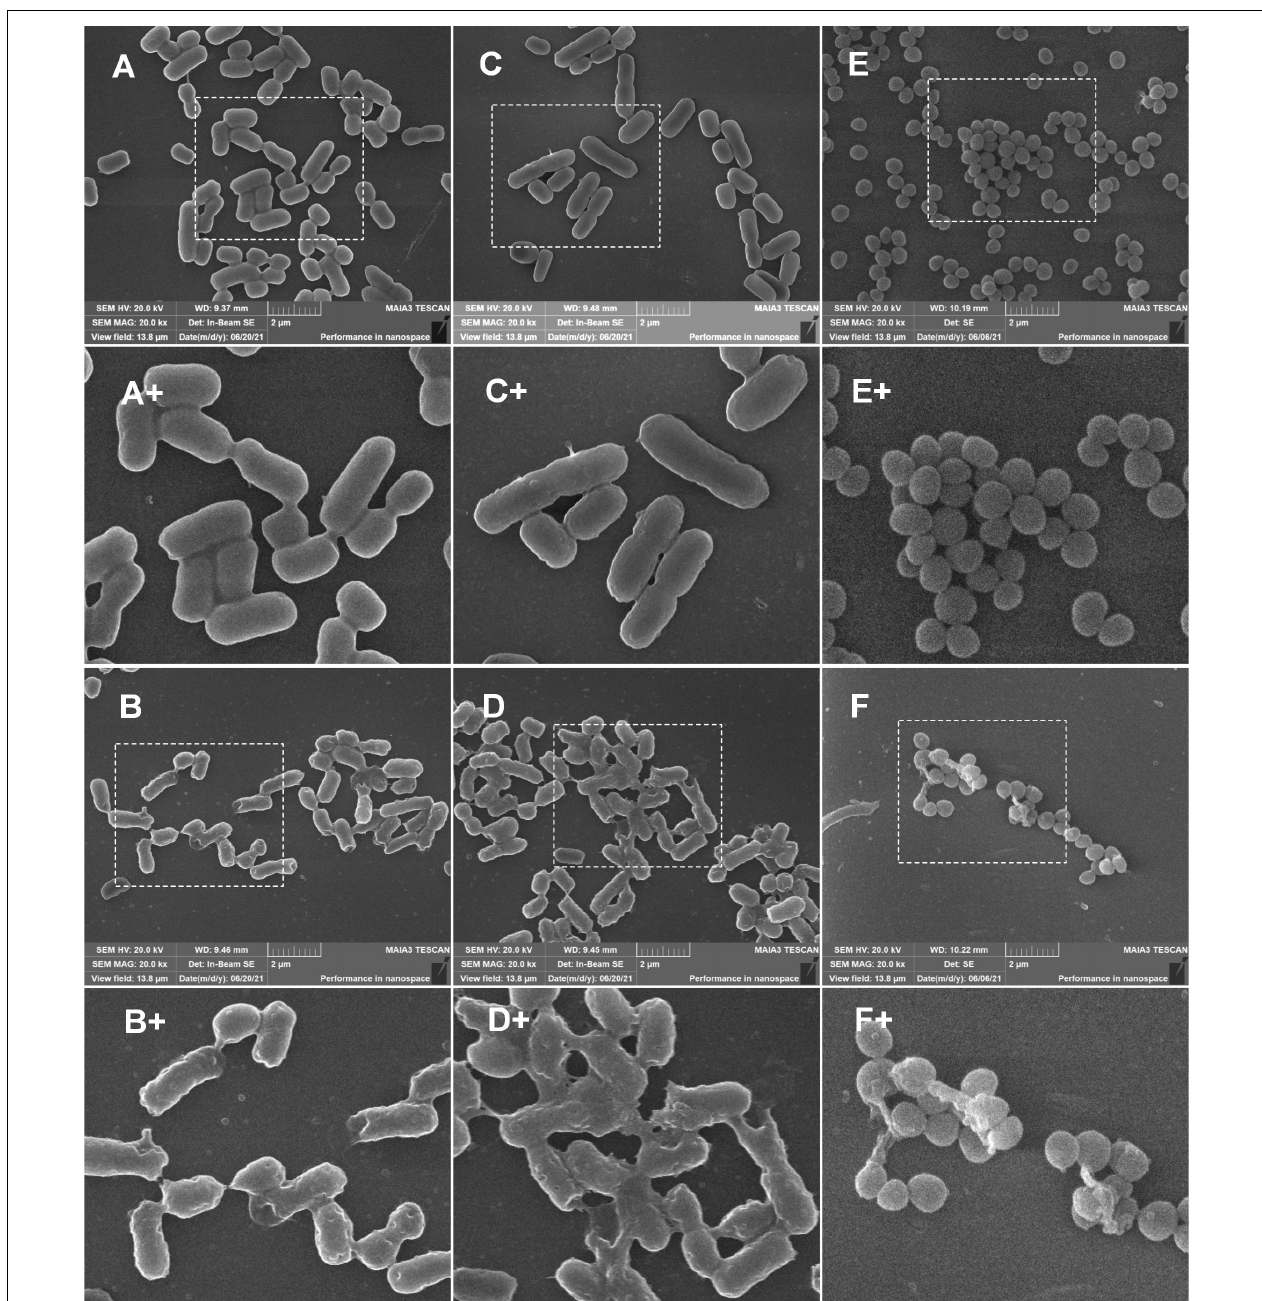
FIGURE 11 | SEM observation of bacterial morphology. (A,C,E) Was untreated E. coli (CMCC44103), E. coli (SYPB-3820), and S. aureus (CMCC26003). (A+,C+,E+) Were the partial enlarged details of (A,C,E) , respectively. (B,D,F) Were E. coli (CMCC44103), E. coli (SYPB-3820), and S. aureus (CMCC26003) treated with S1, S2, and S3, respectively. (B+,D+,F+) Were the partial enlarged details of (B,D,F) , respectively.